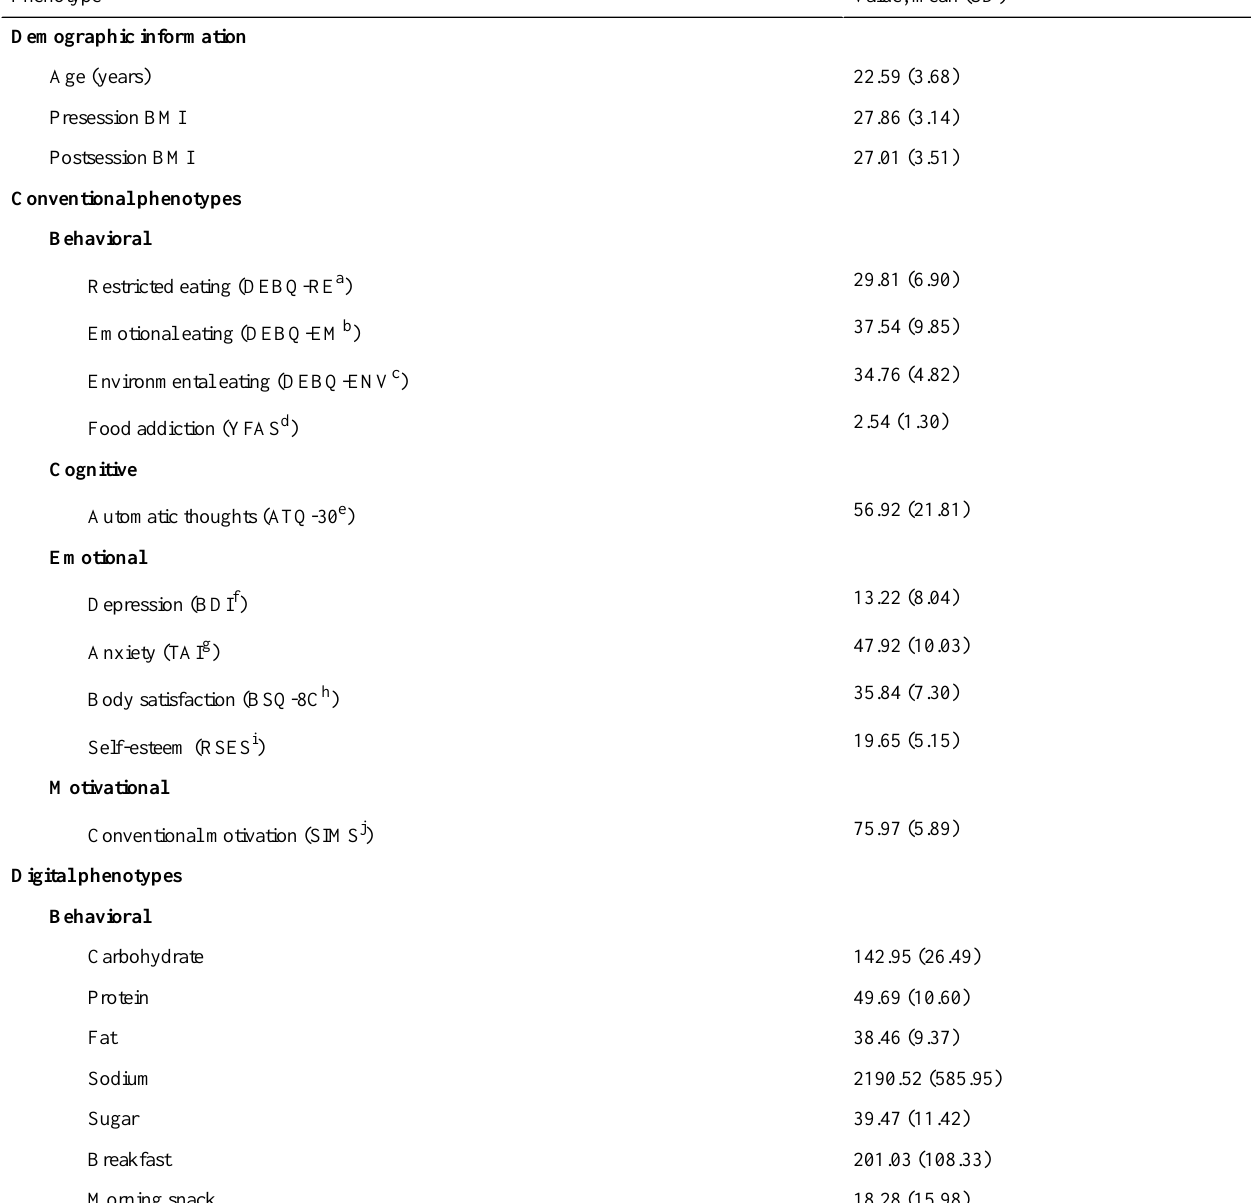
Table 1. Participant characteristics on demographic, behavioral, cognitive, emotional, and motivational